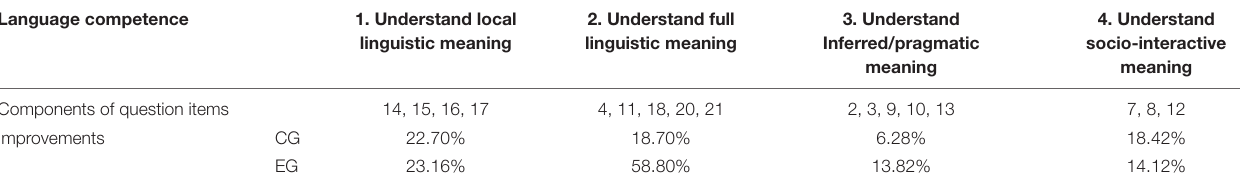
TABLE 9 | Analysis of achievements within the four categories. Language competence